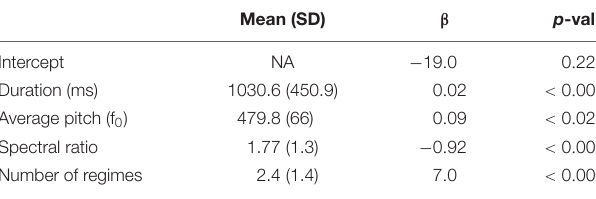
TABLE 2 | Parameters selected in the backward selection method model for predicting rated level of distress based on acoustic